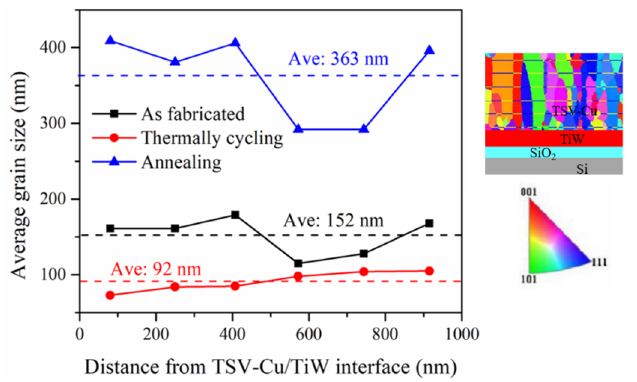
Figure 8. The distribution of TSV-Cu grain size according to distance from the TSV-Cu/TiW